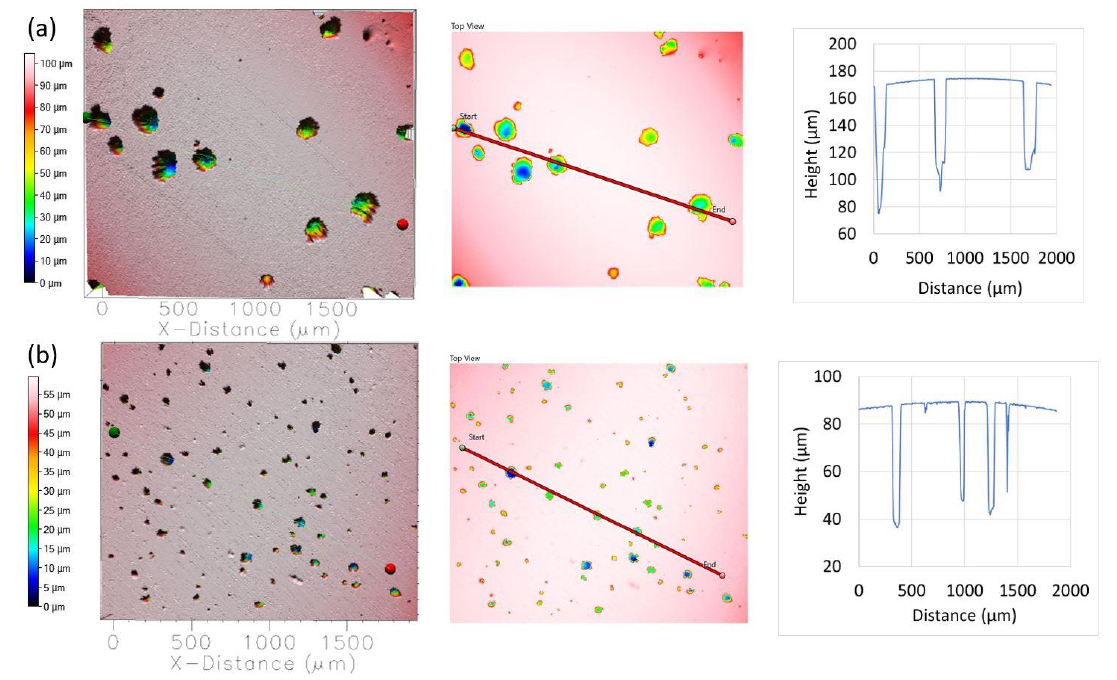
Figure 12. Topographic view of the segment of corroded surfaces in seawater at 298 K after potentiodynamic polarization measurement for ( a ) AISI 304L and ( b ) AISI 316L. The depth and width of pits are determined along the red lines.